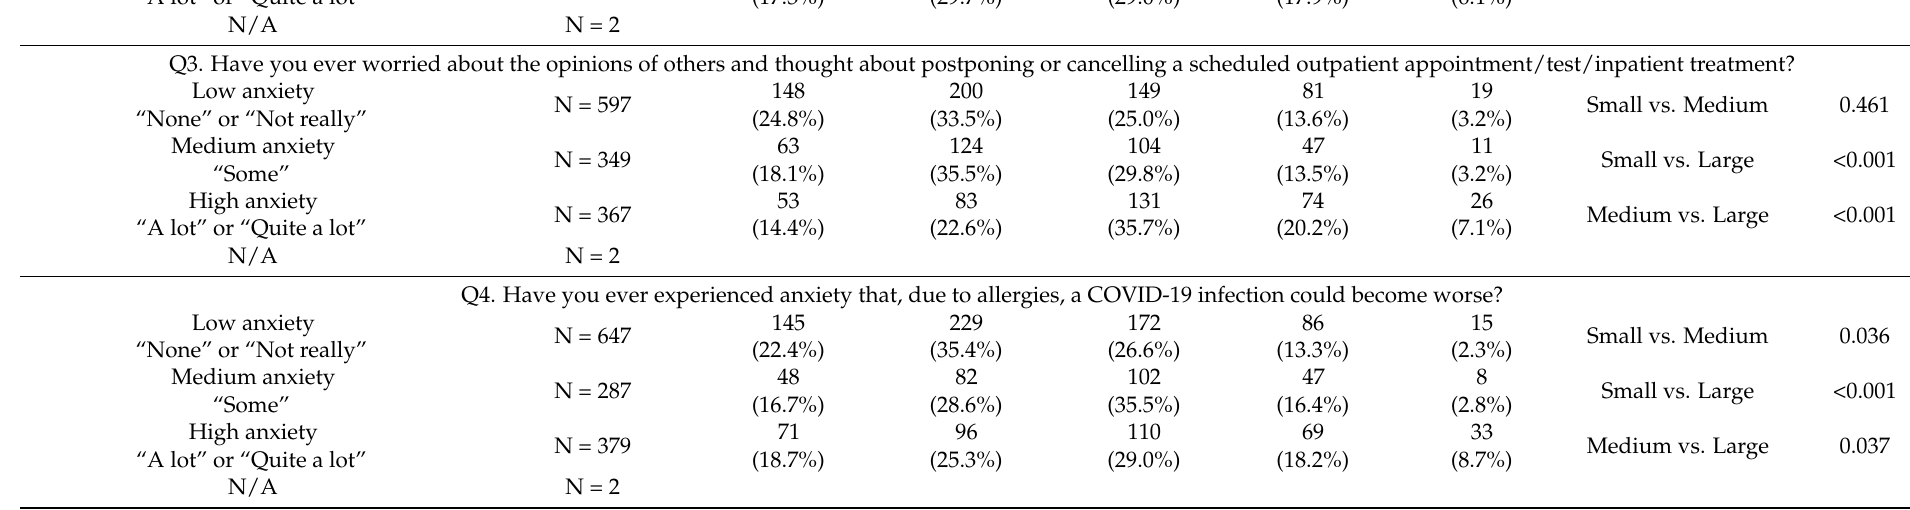
( χ 2 -Test)Full Middle Low Little